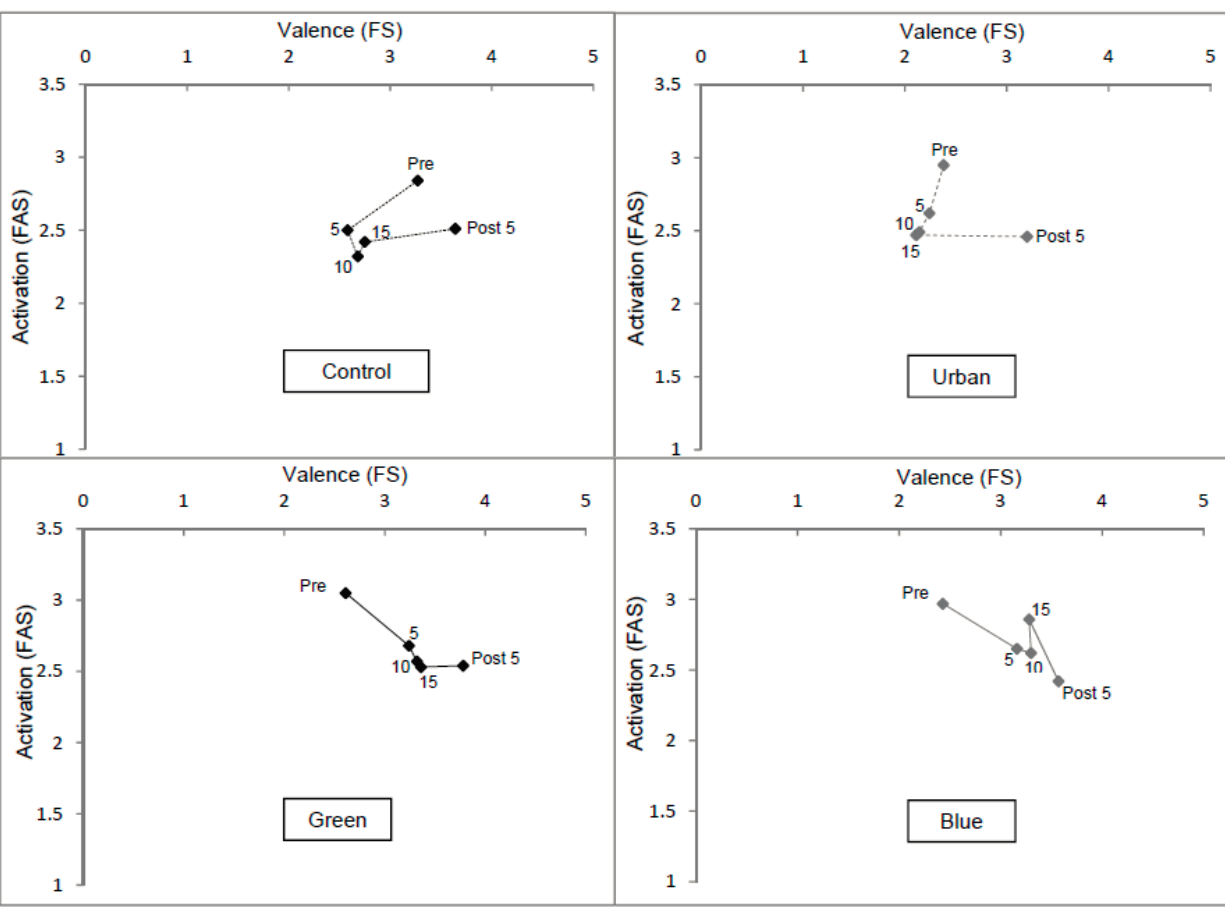
Figure 2. Valence (FS) and Arousal (FAS) during the four trials (times in